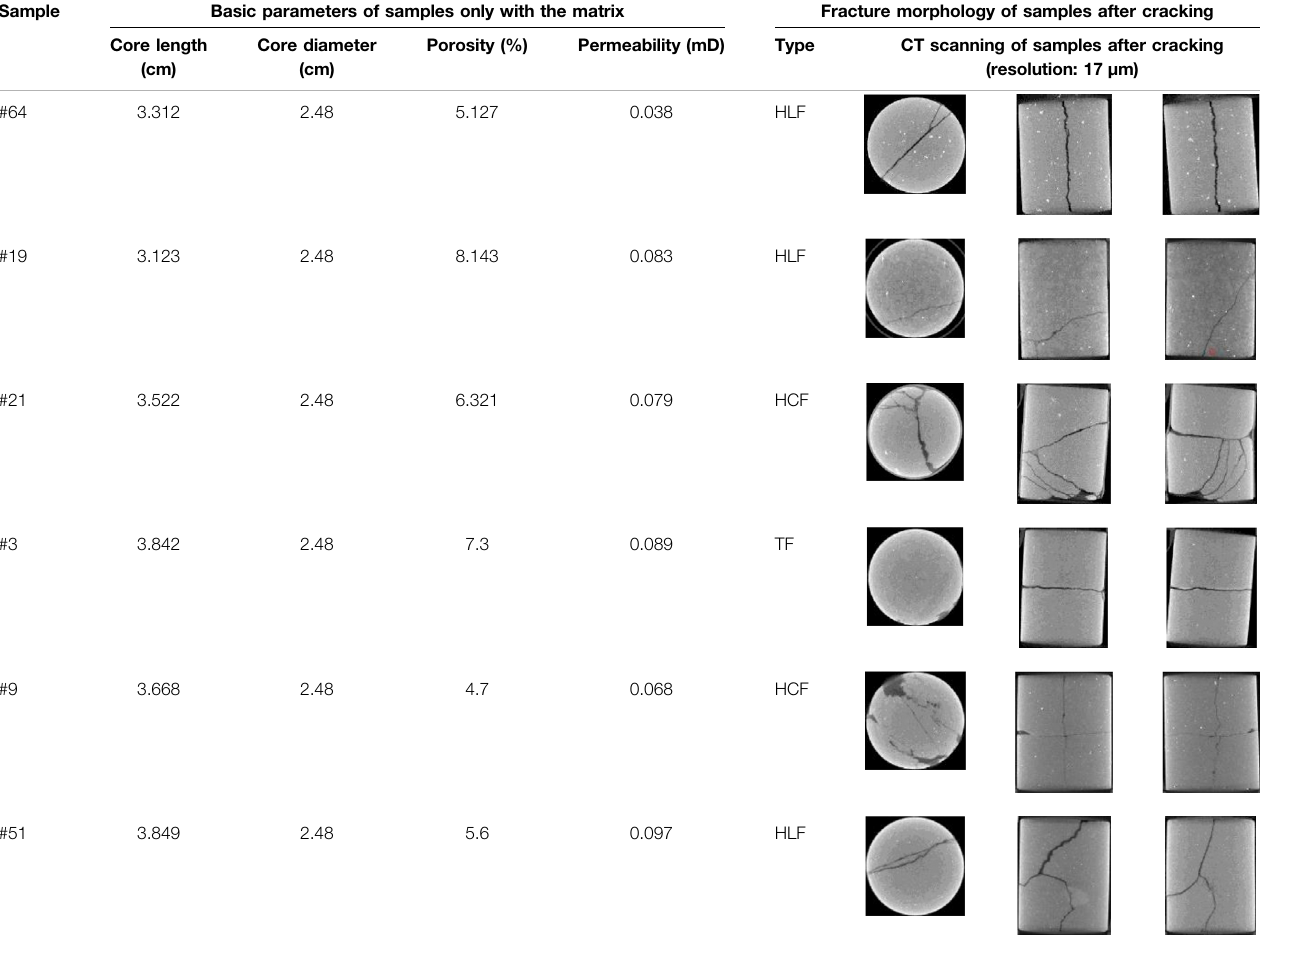
TABLE 1 | Basic information of samples in the NMR experiment of saturated water – gas drive. Sample Basic parameters of samples only with the matrix Fracture morphology of samples after cracking Core length